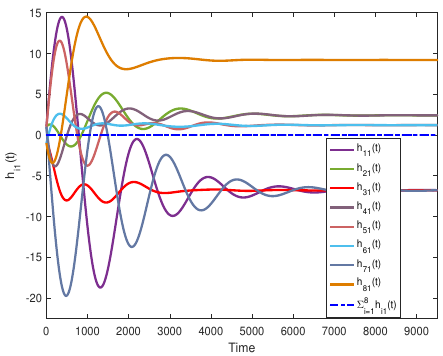
Figure 6. The trajectories of h i 1 ( t ) .